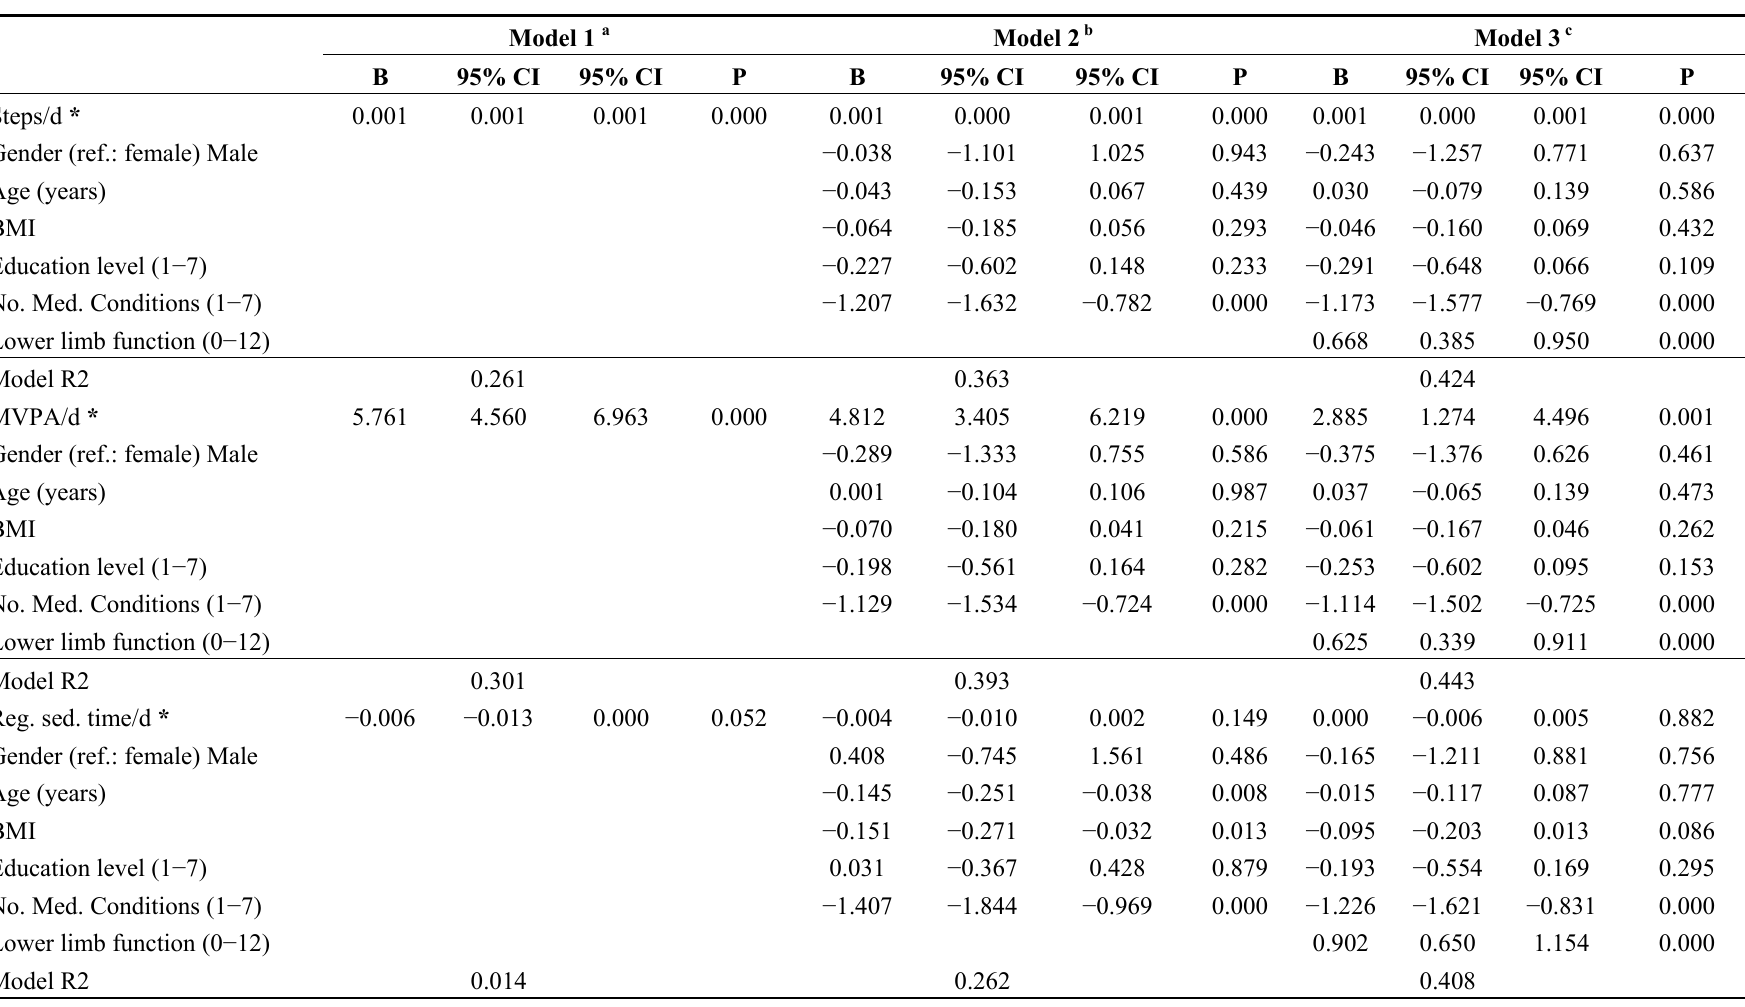
Table 3. Linear regression analysis on SF Physical scores with participant characteristics, number of medical conditions, lower limb function, MVPA, steps and sedentary